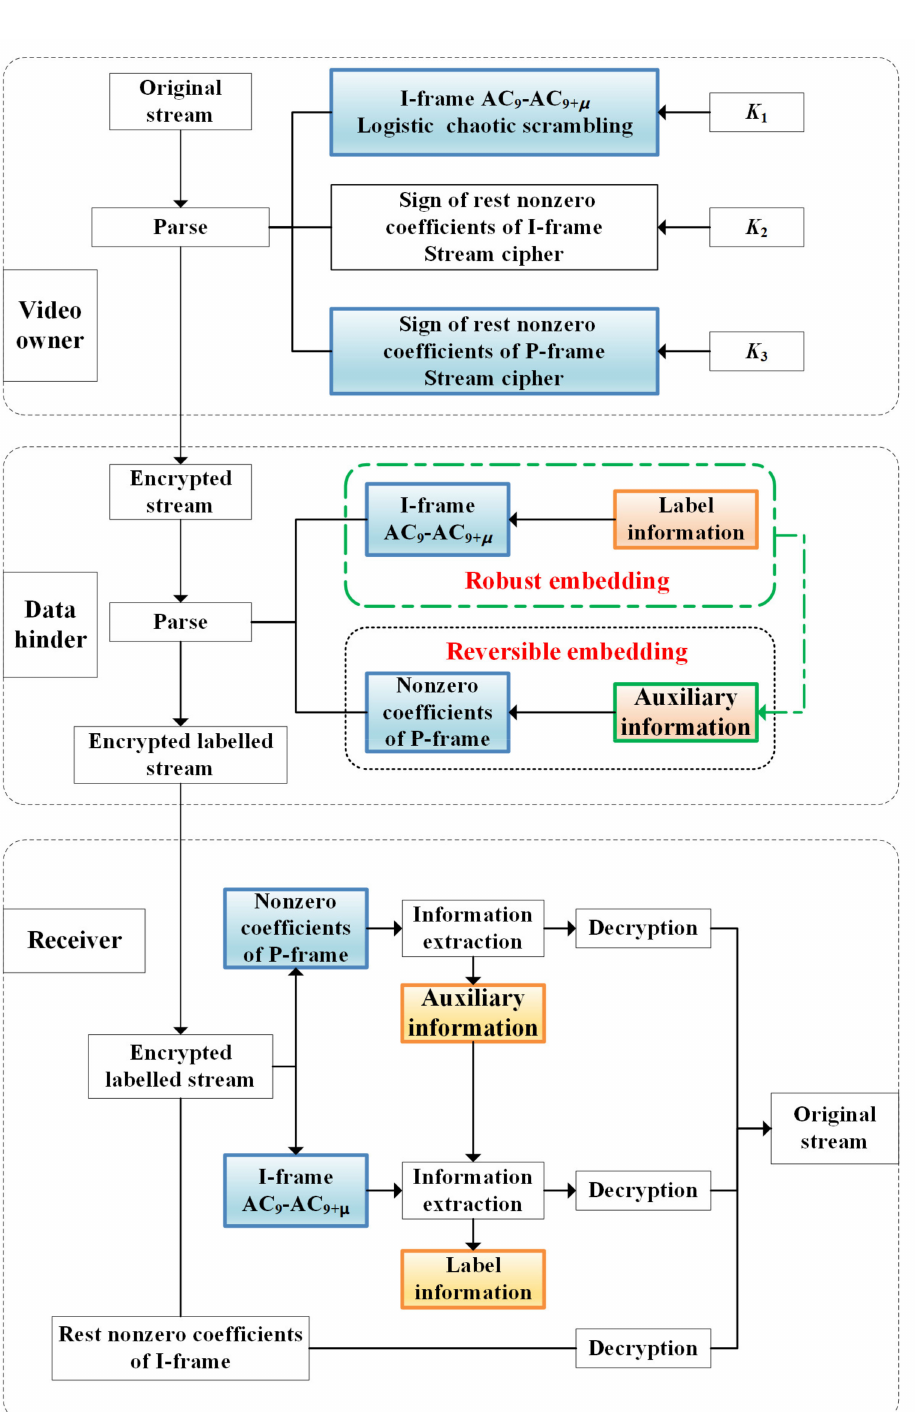
Figure 2. Scenario